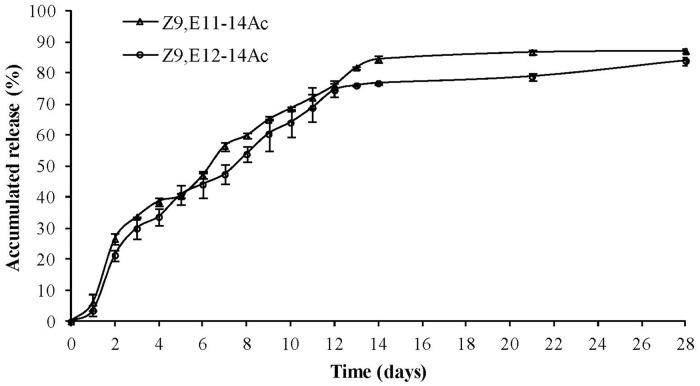
Plot of accumulated release with time in case of sex pheromone-loaded MPEG5000-PCL2000 micelles.The S. litura sex pheromone has two components, Z9,E11-14:Ac and Z9,E12-14:Ac. Data are expressed as means ± S.D. (n = 3).